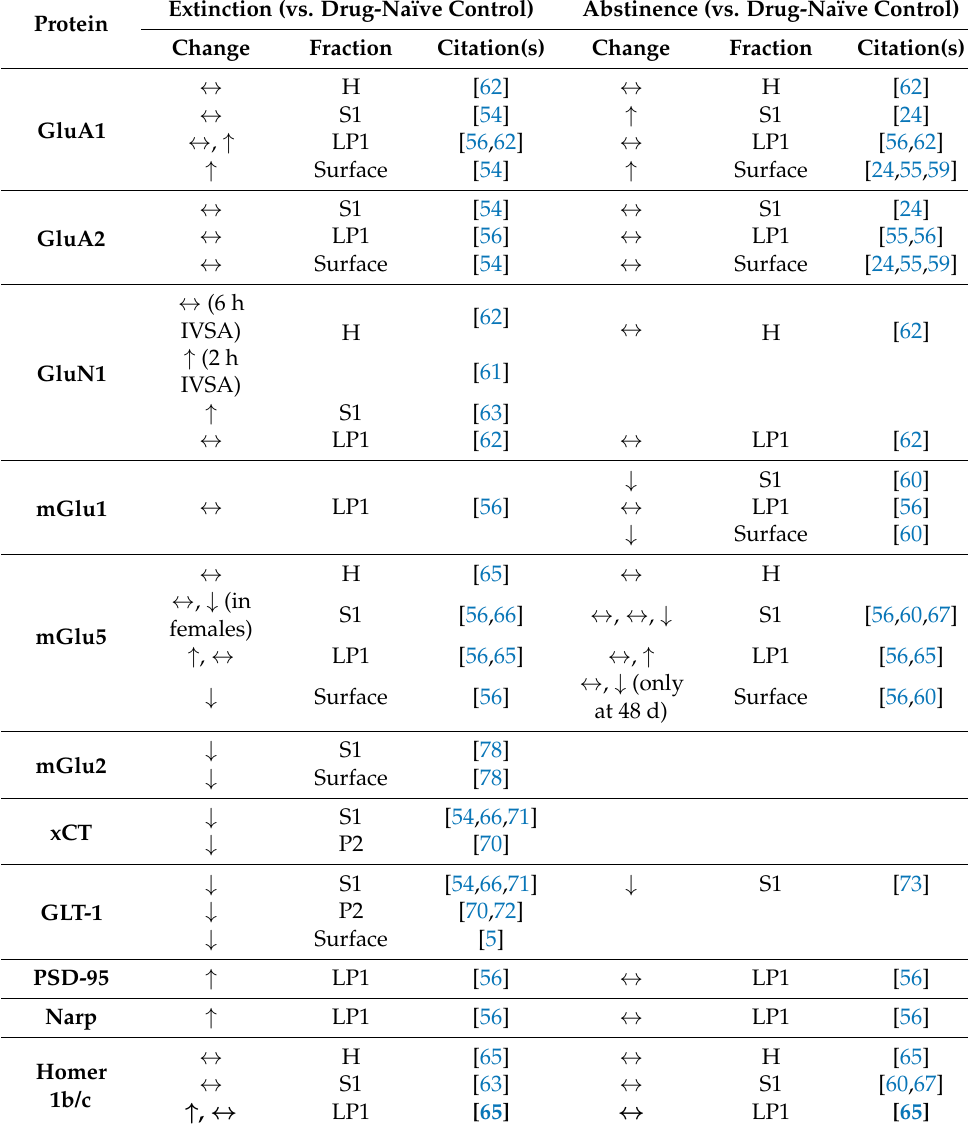
Table 2. NA core protein changes after ≥ 10 days of extinction or abstinence from cocaine self- administration. H= Whole tissue homogenate. S1 = total protein fraction without nuclear material. P2 = membrane-enriched fraction. LP1 = post-synaptic density-enriched fraction. Surface = surface membrane